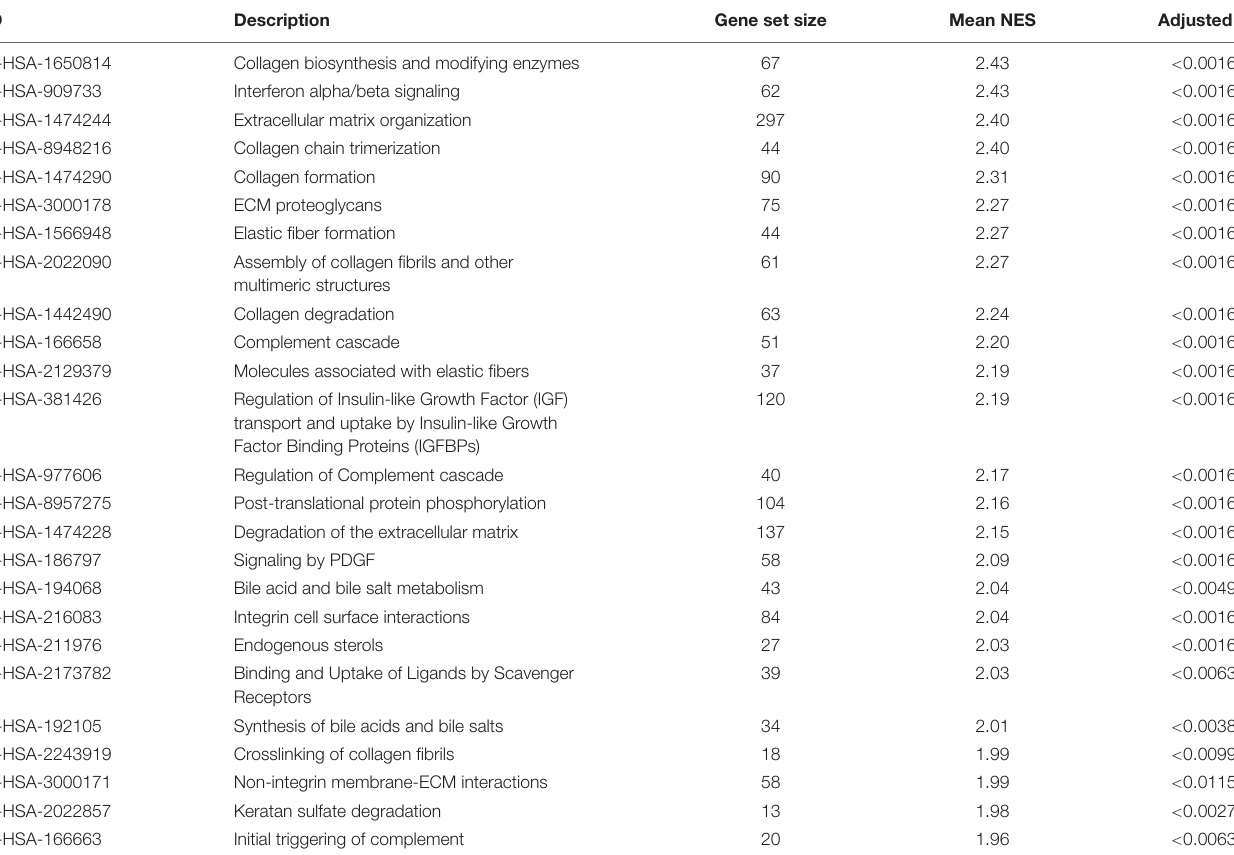
TABLE 2 | Top25 upregulated pathways overrepresented with NES > 1.5 and adjusted p -value < 0.05 in each of the three fibroblast strains (GS3, GS4, and GS5) on day 3 after irradiation with 1 × 4 Gy (MA protocol).